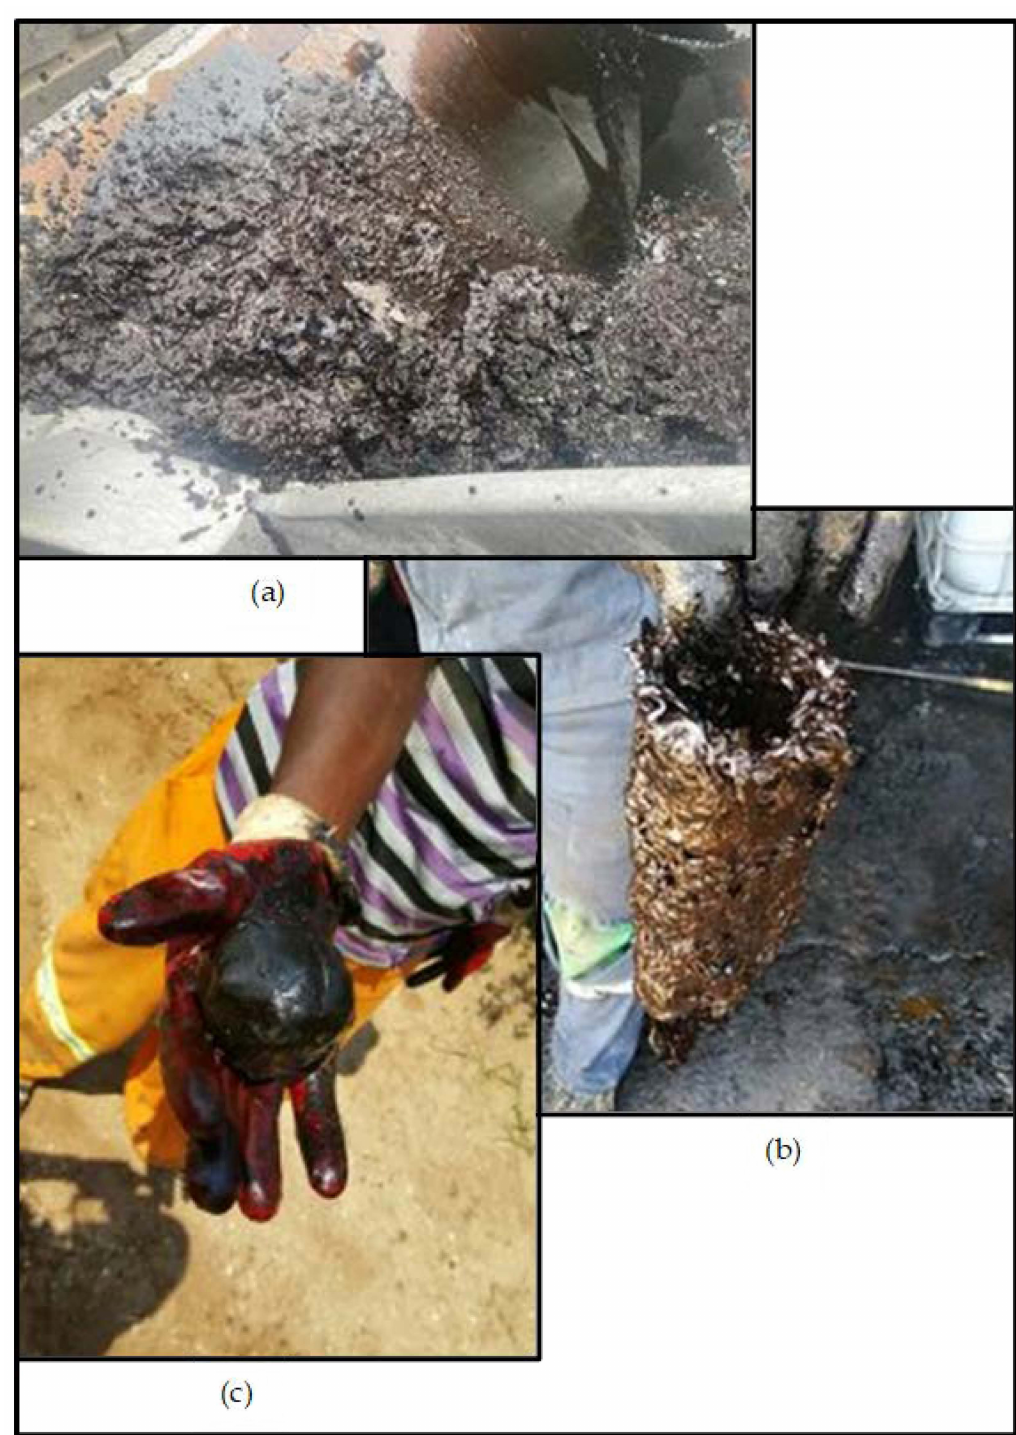
Figure 6. ( a , b ) Typical examples of residue and the state of equipment found during the pre-inspection of “clean” equipment of contractors for use for the stabilisation of granular materials using an anionic NME stabilising agent. ( c ) Typical example of an anionic NME stabilising agent that has been added to the construction water-bowser containing residue from previous operations, resulting in a reaction with the residue, resulting in an unusable “blob” of bituminous